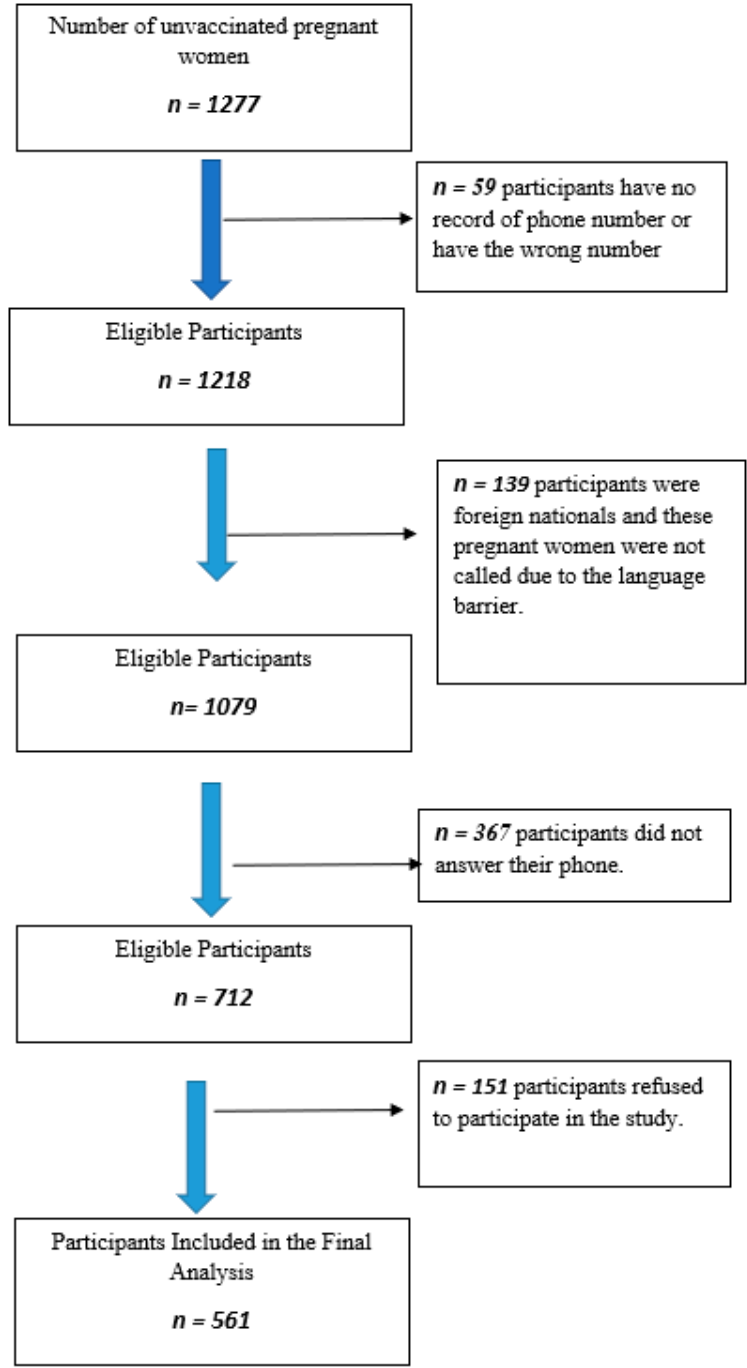
Figure 1. Flow chart on participants’ inclusion.